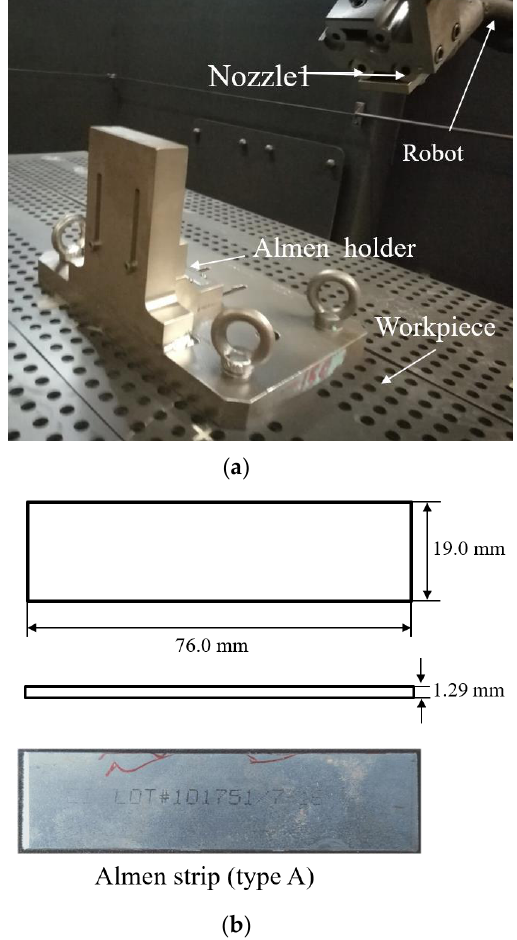
Figure 2. Equipment. ( a ) Shot peening equipment. ( b ) An Almen strip of type A.